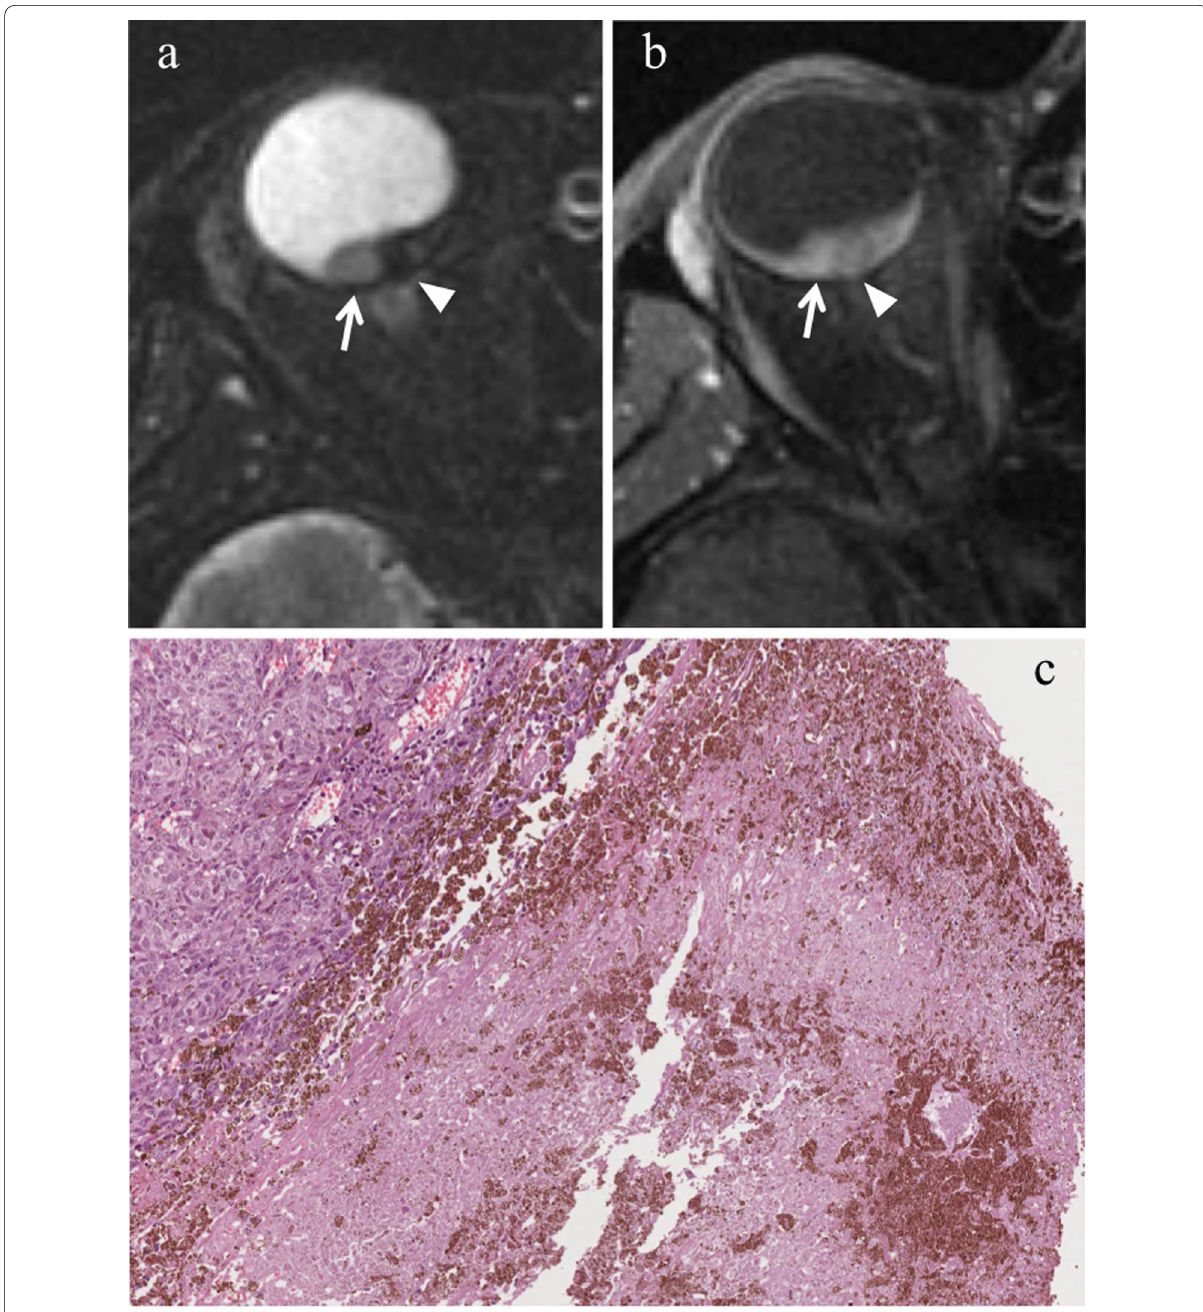
Fig. 4 A 29-year-old man with a choroidal melanoma of the right eye treated with proton-beam radiotherapy. The patient underwent secondary enucleation about three years after radiotherapy. Axial a T2-weighted turbo spin-echo STIR and b contrast-enhanced fat-suppressed T1-weighted images display an intraocular lesion along the posterior aspect of globe (white arrows). On T2-weighted image, a central well-marginated hypointense area is detectable within the mass (white arrowhead); it represents radiotherapy-related necrosis and its low signal intensity is due to the dispersion of melanin pigment. On contrast-enhanced T1-weighted image, the above-mentioned area appears relatively hypointense (white arrowhead) compared to the surrounding enhancing viable neoplastic tissue. c Histological examination showing an “abrupt transition” between a radiotherapy-related necrotic area with dispersion of melanin pigment (on the right) and the vital tumor tissue (on the left) (H&E, original magnification 100 ×